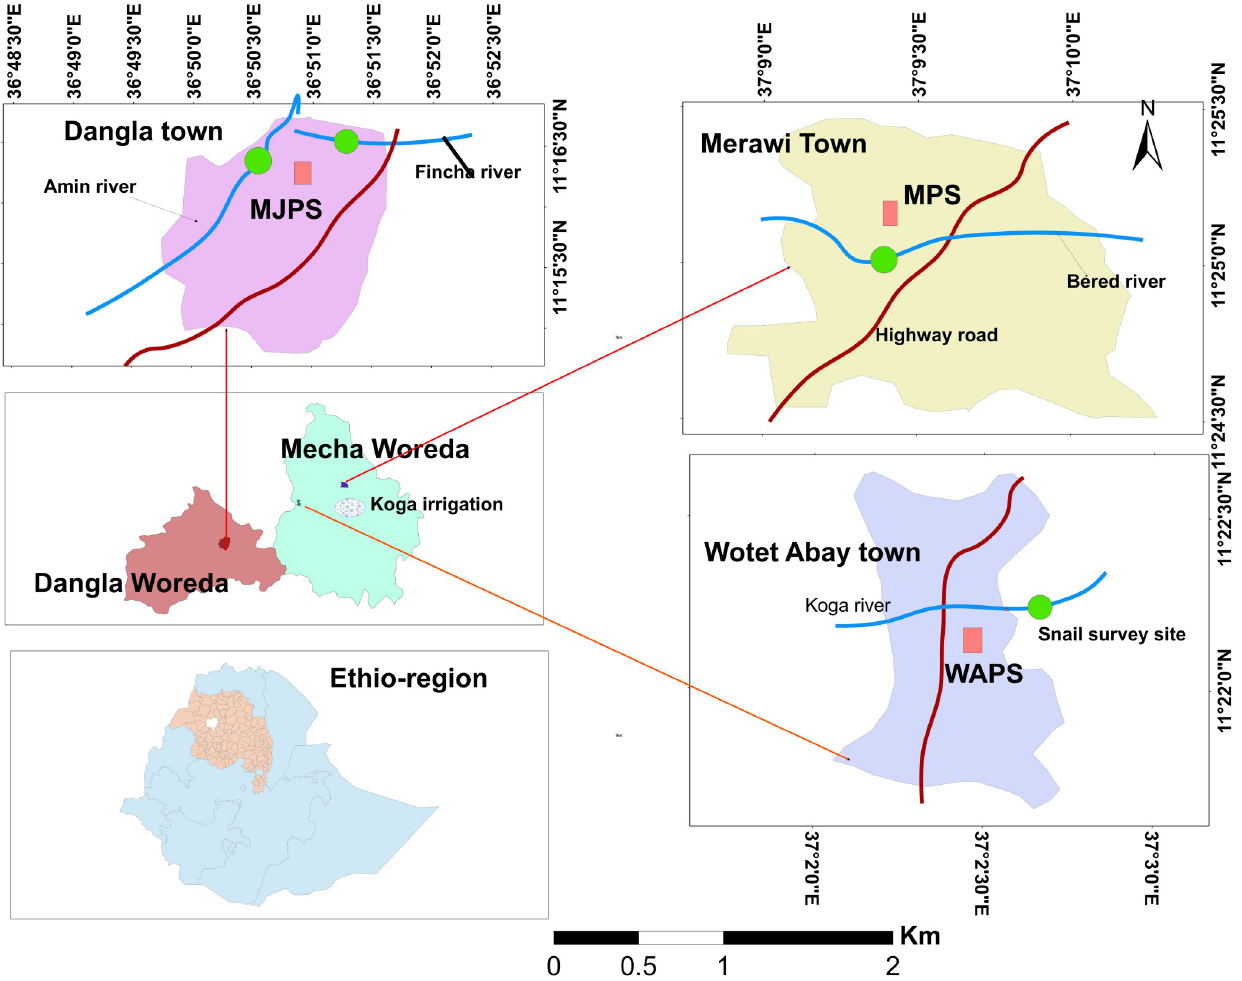
Fig 1. Map of the study area and data collection